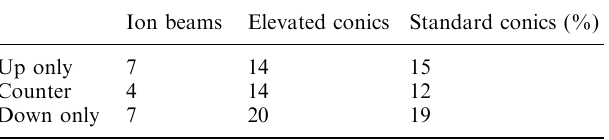
Table 1. Association rates of the three types of field-aligned electron beams with the three types of upflowing ions: ion beams, elevated conics, and standard